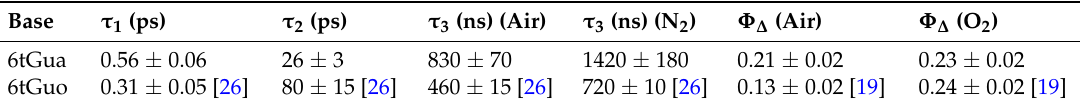
Figure 7. 1 O 2 phosphorescence signal measured at 1270 nm from air- and O 2 -saturated solutions of 6tGua and the standard phenalenone ( Φ Δ = 0.98) [52] in Tris buffer at pH 7.4 following pulsed excitation at 355 nm (7 ns pulse width). Table 2. Lifetimes of 6tGua extracted from global fitting of transient absorption data. Also included are those reported for 6tGuo in PBS pH 7.4 [19,26].